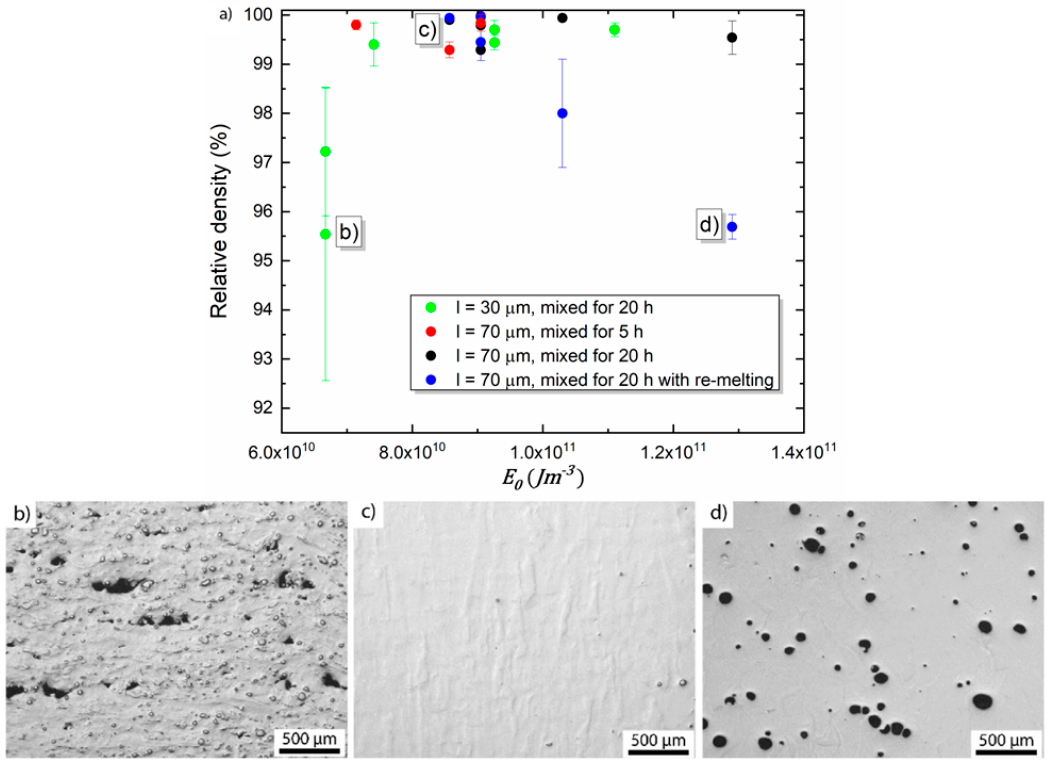
Figure 2. ( a ) Relative density as a function of (cid:1831) (cid:3042) . In ( b ), lack of fusion defects as well as unmelted powder particles are found for low (cid:1831) (cid:3042) . Sample parameters are (cid:1843) = 360 W, (cid:1874) = 2 m/s, ℎ = 80 µm, (cid:1864) = 30 µm, and (cid:1870) (cid:3029) = 45 µm. ( c ) Full density for intermediate values of (cid:1831) (cid:3042) . Sample parameters are (cid:1843) = 360 W, (cid:1874) = 0.3 m/s, ℎ = 120 µm, (cid:1864) = 70 µm, and (cid:1870) (cid:3029) = 100 µm. ( d ) Keyhole defects are observed for high (cid:1831) (cid:3042) and re-melting. Samples parameters are (cid:1843) = 380 W, (cid:1874) = 0.3 m/s, ℎ = 120 µm, (cid:1864) = 70 µm, and (cid:1870) (cid:3029) = 100 µm. Building direction is upward for all images.